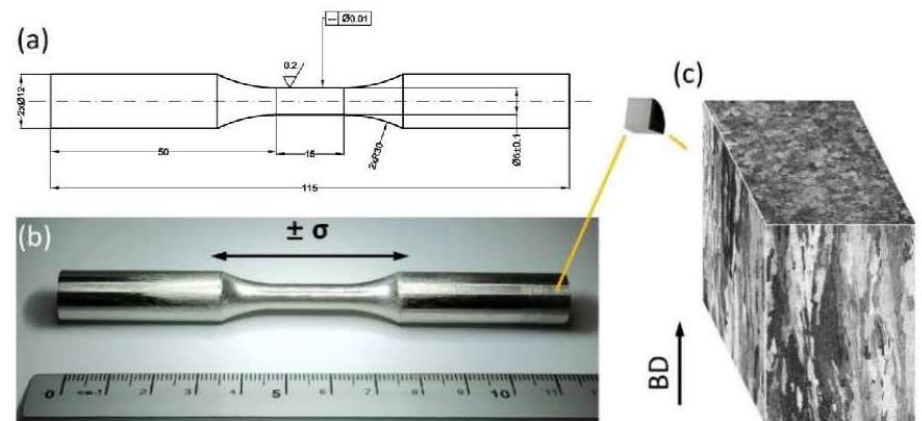
Figure 1. ( a ) The geometry (unit: mm) of the fatigue specimen used in this study; ( b ) the image of representative fatigue bar; ( c ) optical micrographs of the specimen before fatigue testing. The fatigue loading direction is perpendicular to the BD.